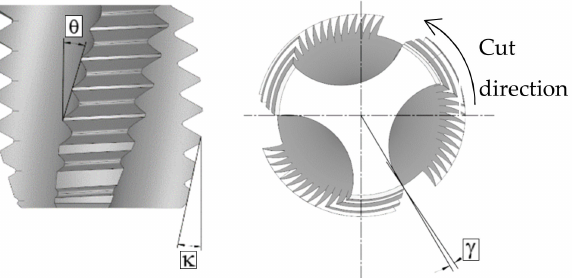
Figure 1. Spiral fluted tap with chamfer angle ( κ ), rake angle on cutting edge ( γ ) and helix angle of flute ( θ ).